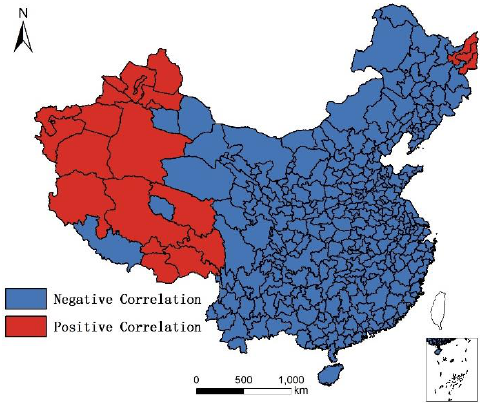
Figure 19. Distribution of negative/positive correlation between altitude and longevity.